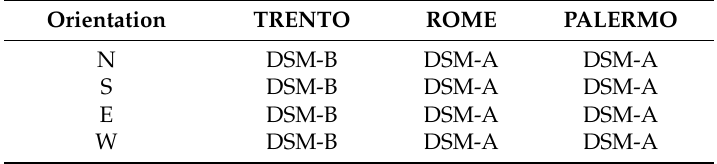
Table 7. Best choice of glazing elements for the three locations and the four orientations studied. Orientation TRENTO